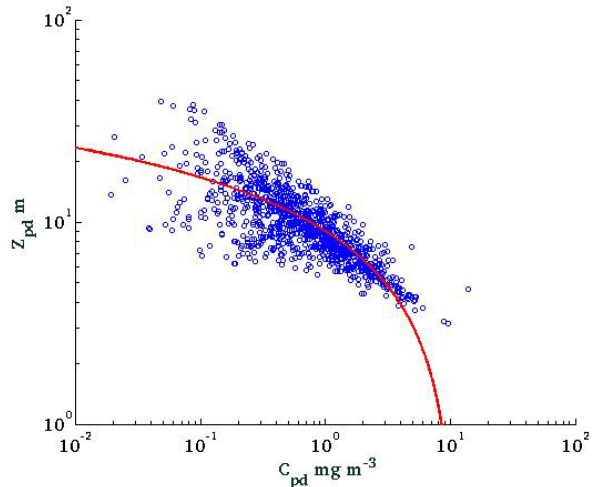
Fig. A3. Penetration depth, also called first optical depth ( Z pd ) , versus mean chlorophyll within the surface layer ( C pd ) . R = 0.71, N = 1199, significant correlation ( p < 0.0001). Red line is the re- gression